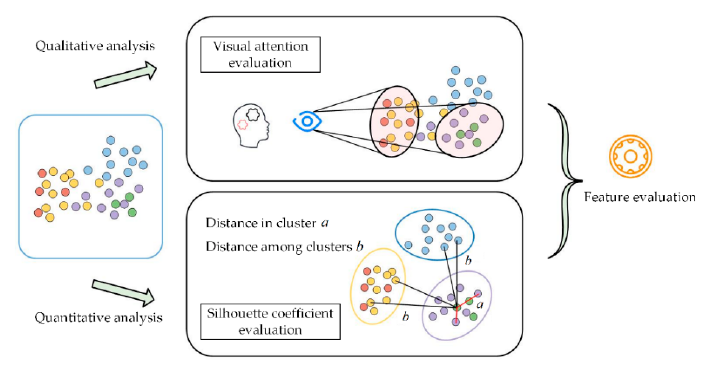
Figure 4. Schematic diagram of feature evaluation.